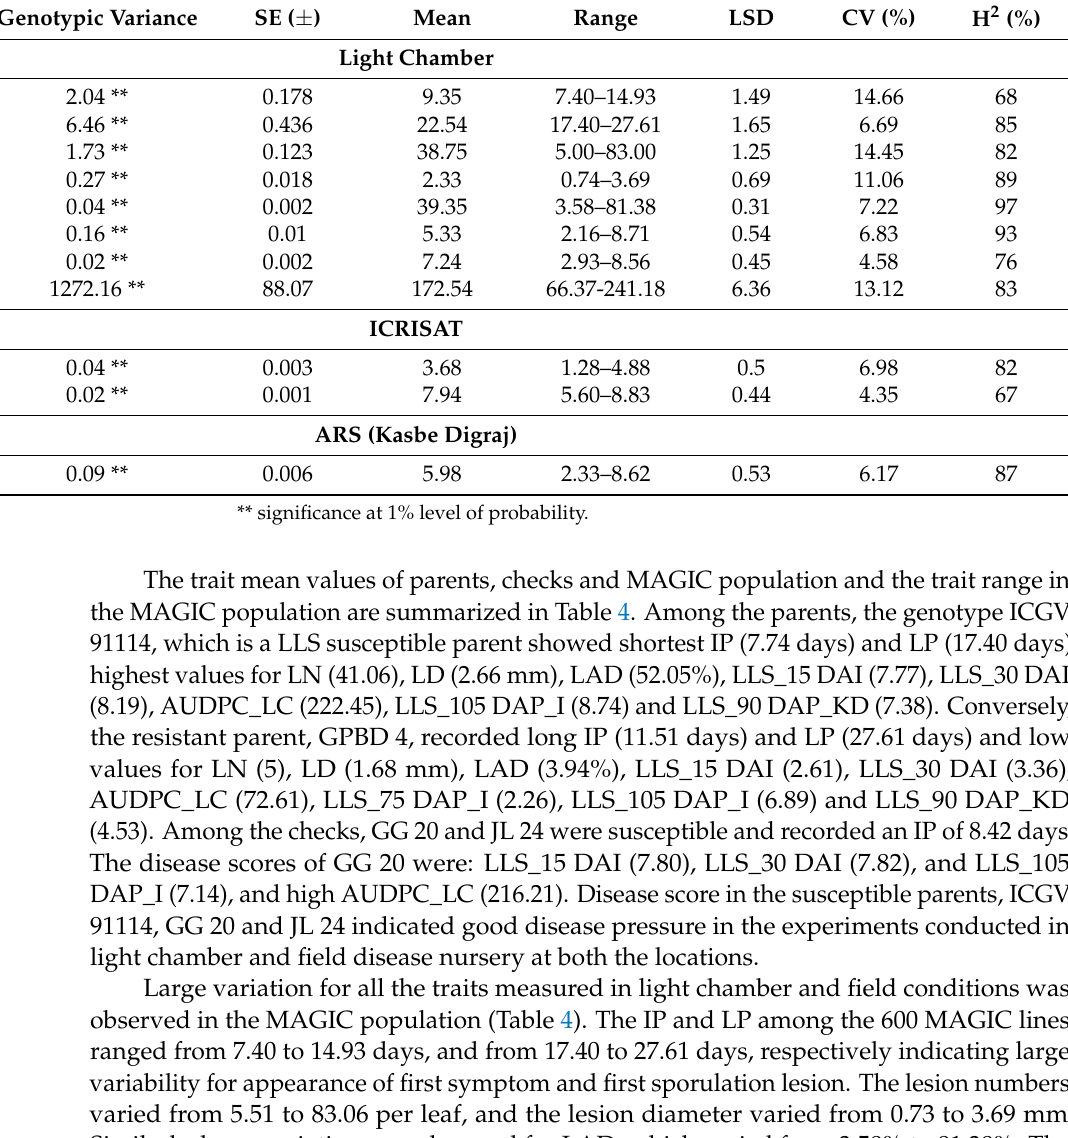
genotypes. Coefficient of variation (CV) between 4.58% to 14.66% was observed for various traits recorded in light chamber and CV was high for IP (14.66%) and LN (14.45%) and low for LLS_105_DAP_I (4.35%). High heritability of >60% was recorded for all the traits under this study. The highest heritability value of >90% was observed for LAD% (97.00) and LLS_15_DAI (93.00). Table 3. ANOVA and descriptive statistics for LLS resistance component across light chamber and disease screening nursery. Trait Genotypic Variance SE ( ± ) Mean Range LSD CV (%) H 2 (%) Light Chamber IP 2.04 ** 0.178